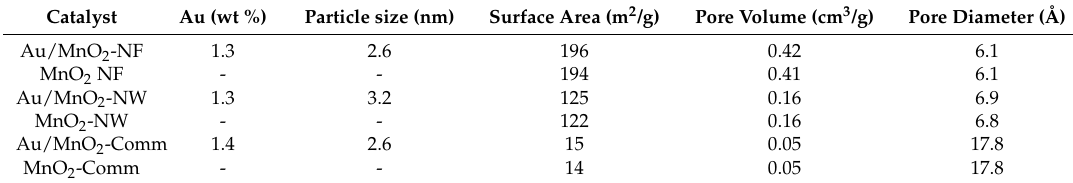
Table 1. Au wt %, Au gold particle size, BET surface area, pore volume and pore diameter determined by FAAS, TEM and BET - N 2 adsorption, respectively.